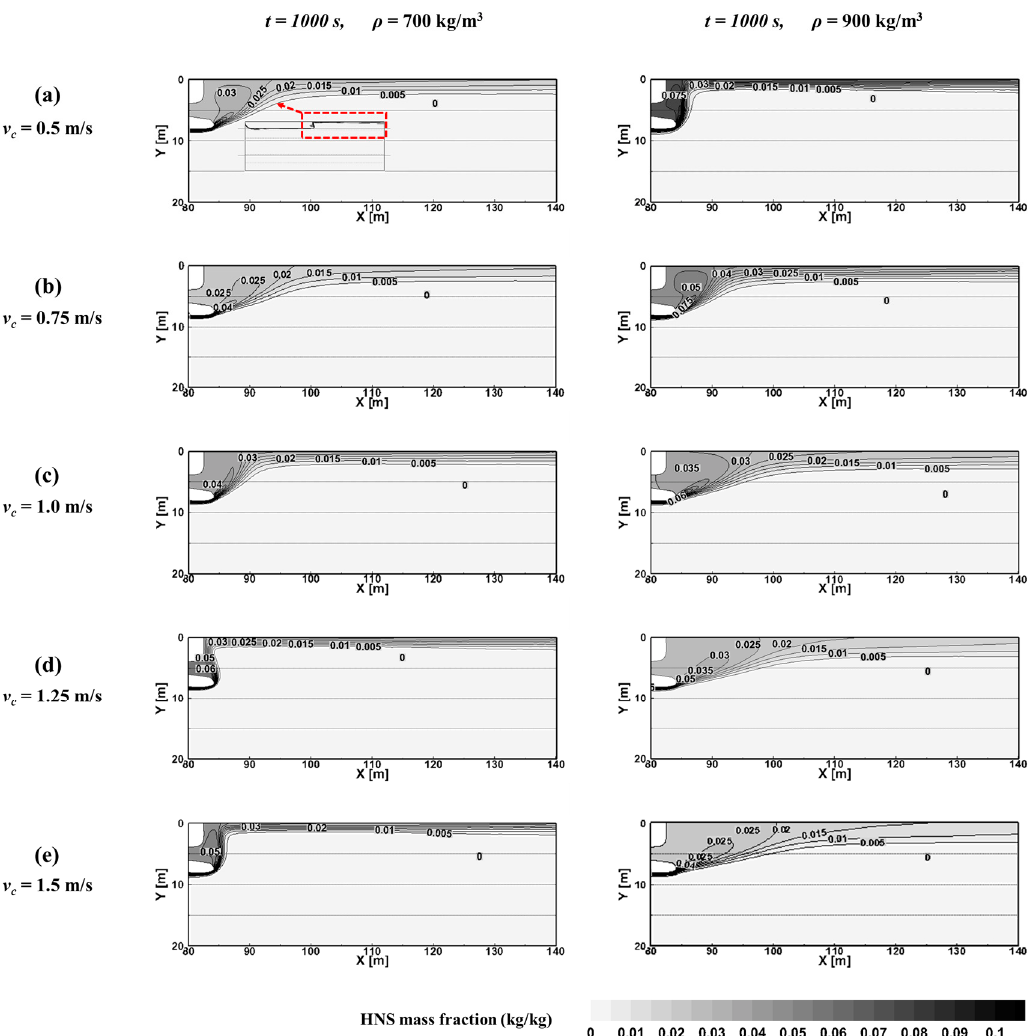
Figure 4. Distribution of hazardous noxious substance (HNS) mass fraction at t = 1000 s after leakage: